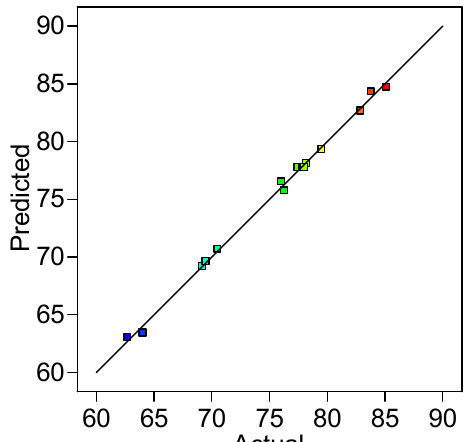
Figure 4. Experimental versus predicted values of RB desorption efficiency.